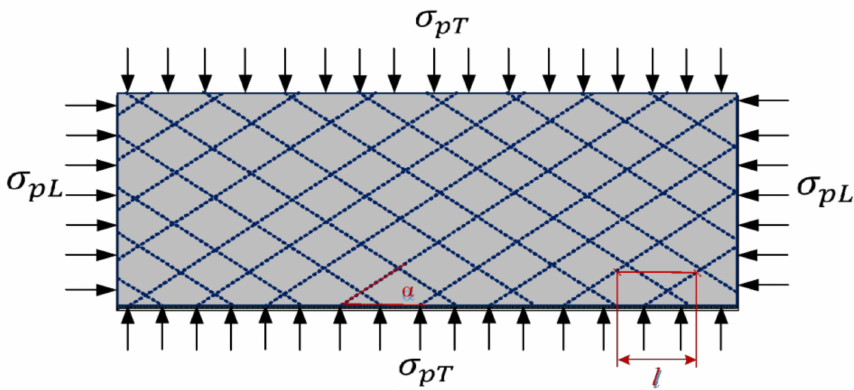
Figure 2. A sample concrete slab with transverse and longitudinal stress under oblique prestressed